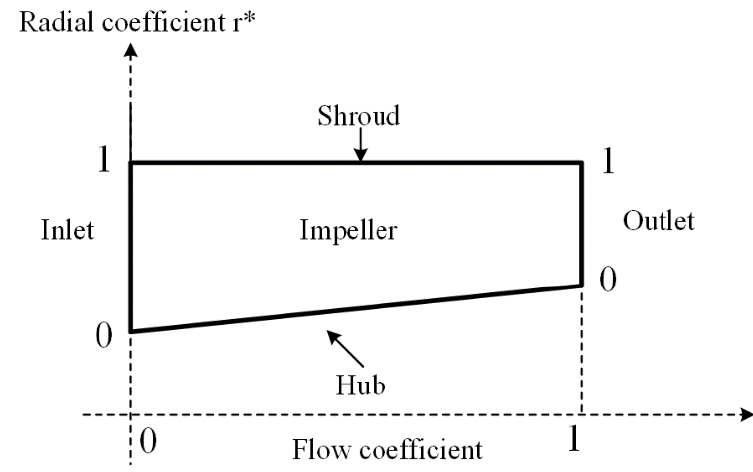
Figure 8. Radial coefficient and flow coefficient in impeller.